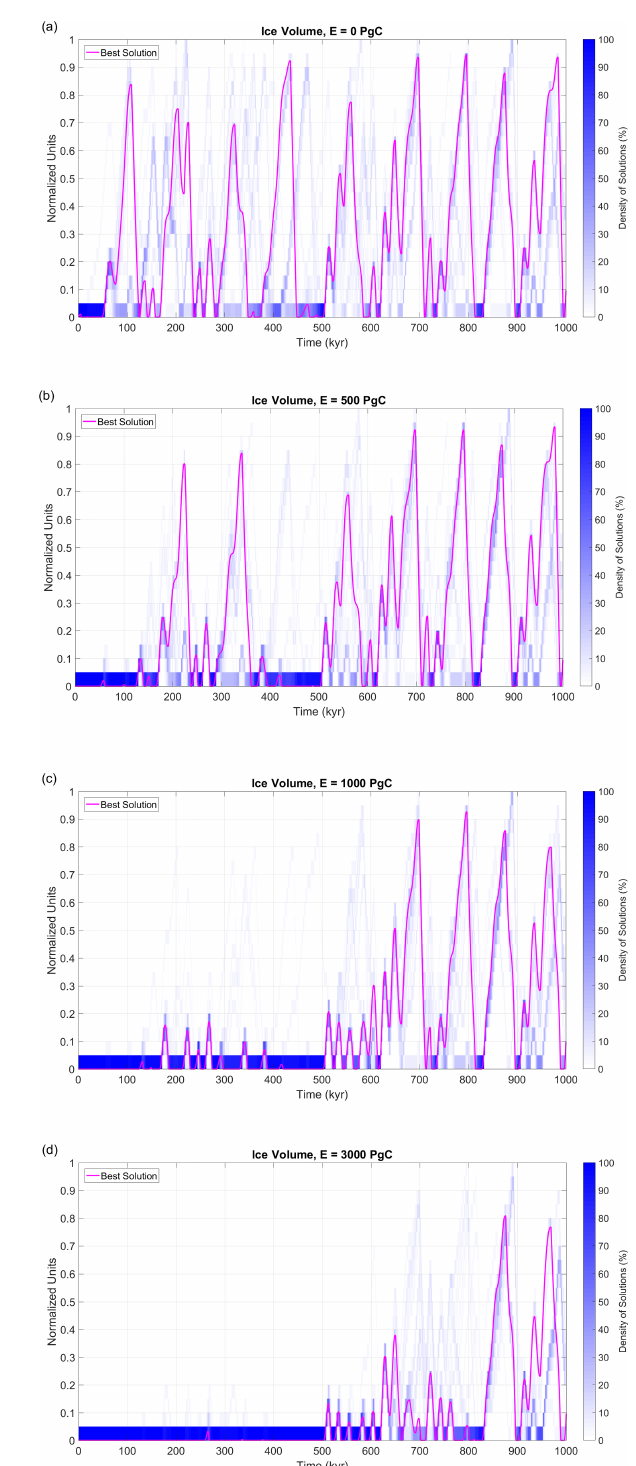
Figure 7. Simulated ice volume for different future scenarios: (a) natural scenario, (b) low-emissions scenario ( E = 500PgC), (c) intermediate-emissions scenario ( E = 1000PgC), and (d) high- emissions scenario ( E = 3000PgC). The magenta line depicts the behaviour of the Best Solution, and the blue shades represent the density of Accepted solutions per unit of phase space (units are 1kyr for time and 0.05 for ice).